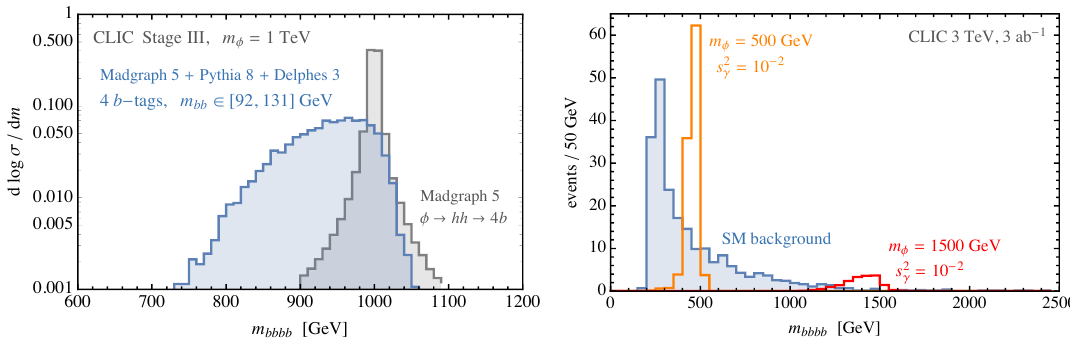
Figure 3. Left: invariant mass distribution of the 4 b -quarks in the signal, for m (cid:30) = 1 TeV at the 3 TeV CLIC. The blue histogram shows the signal after parton showering, detector simulation, and identi(cid:12)cation cuts; the grey line shows the output of the Monte Carlo generator before parton showering. Right: 4 b invariant mass distribution of the SM background, with two examples of signal